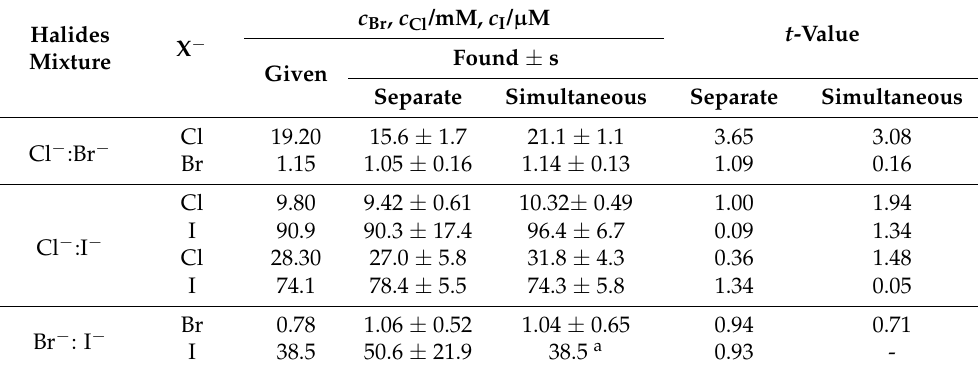
Table 4. The results of analysis of halide mixture by ANN analysis of the experimental data obtained from the plate reader (see details in Figure 7).